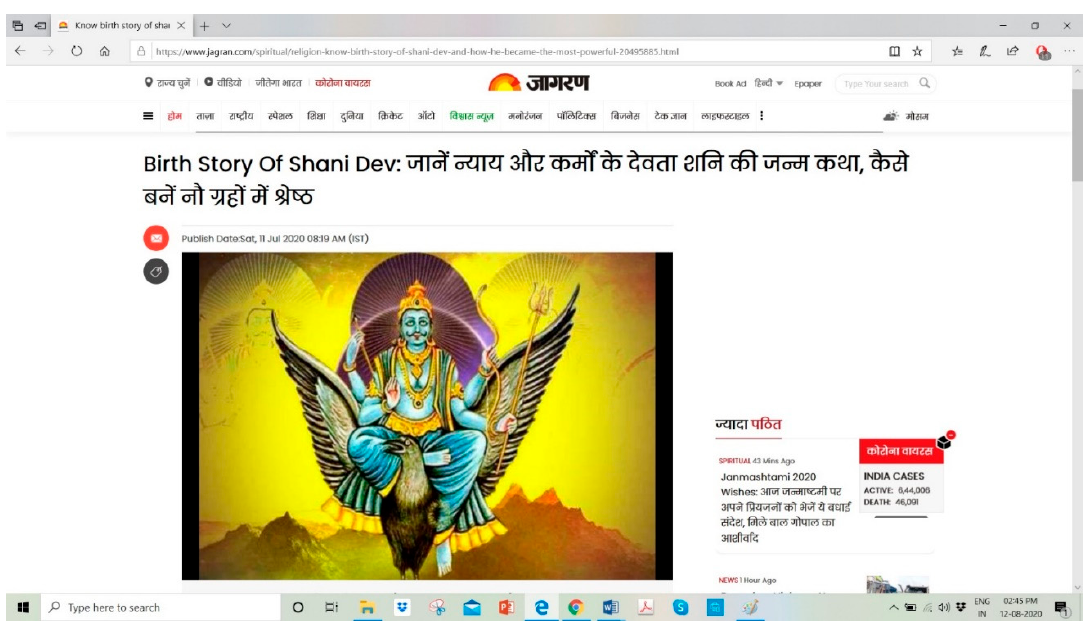
Figure 2. Aniconic Shani from Shingnapur Shanidev Temple. Source: Zee News.